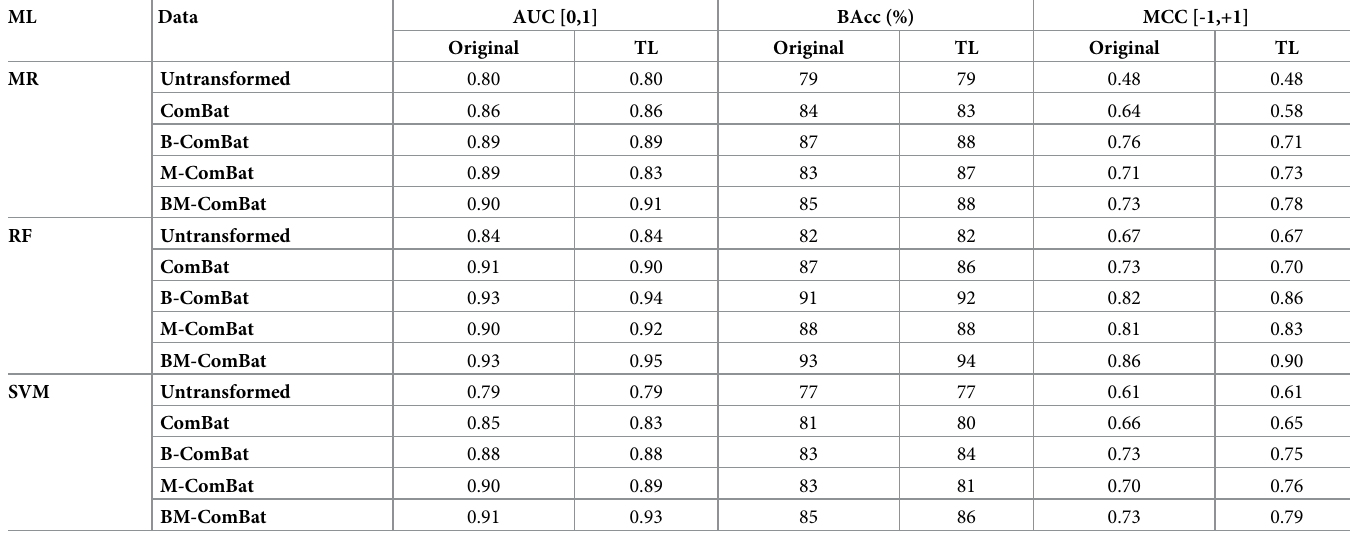
Table 3. Performance metrics evaluation of predictive models in testing sets using the three ML pipelines. ML